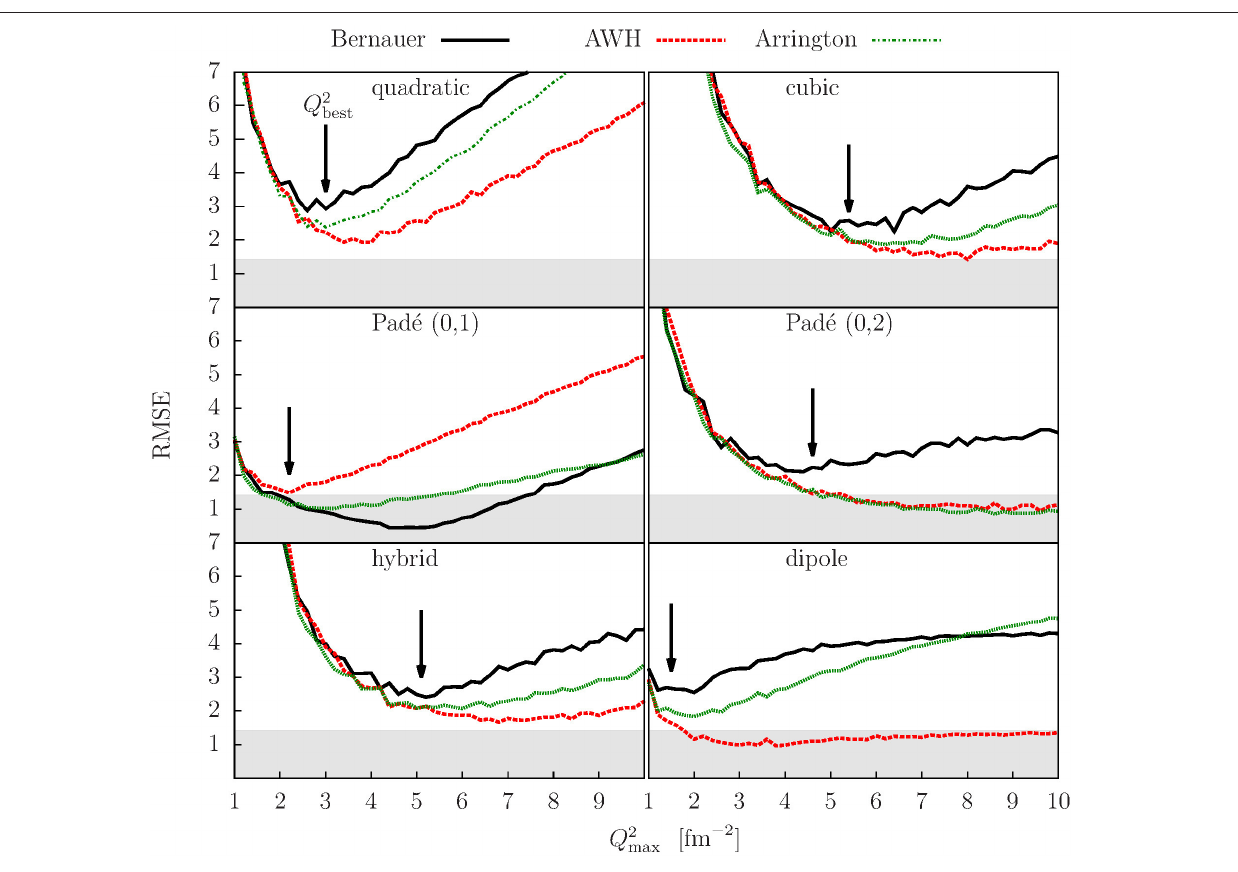
FIGURE 4 | Results of the Monte-Carlo study of the form-factor models (2)–(7). RMSE as a function of Q 2 max , obtained with realistic form factor parameterizations is used to evaluate the behavior of each model. According to our selection criterion a model is appropriate for the analysis if the minima of all the curves on a given plot √ 2. The selection threshold is marked on the plots with gray bands. The black arrows on each plot denote the positions of the highest lie below the threshold of ≈ minimum which determines the interval [0, Q 2 best ] of the data that should be considered in the